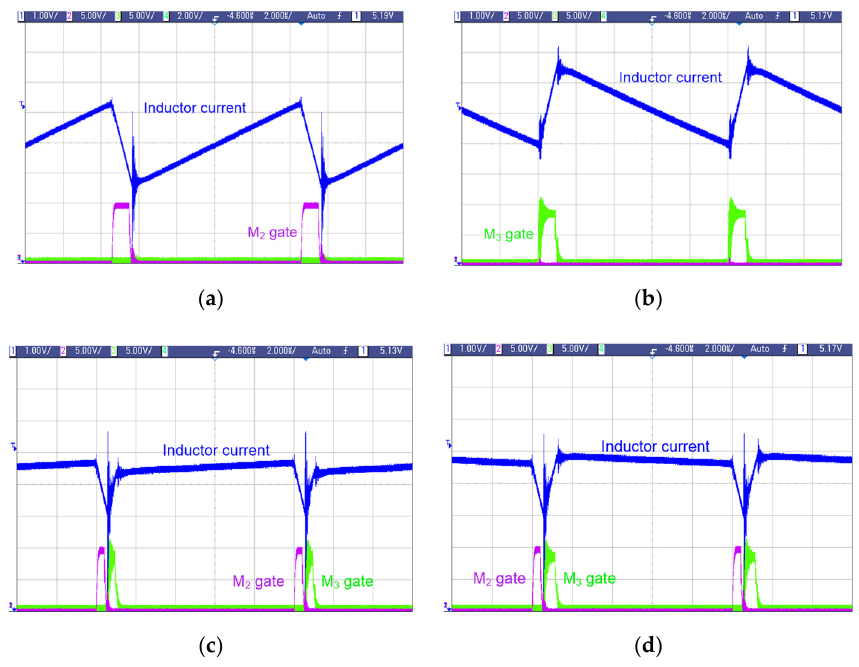
Figure 19. Main operation waveforms in each operation mode. ( a ) Buck mode (d[n] = 0.90), ( b ) Boost mode (d[n] = 1.10) ( c ) Buck+Boost mode (d[n] = 0.98), and ( d ) Buck+Boost mode (d[n] = 1.02.